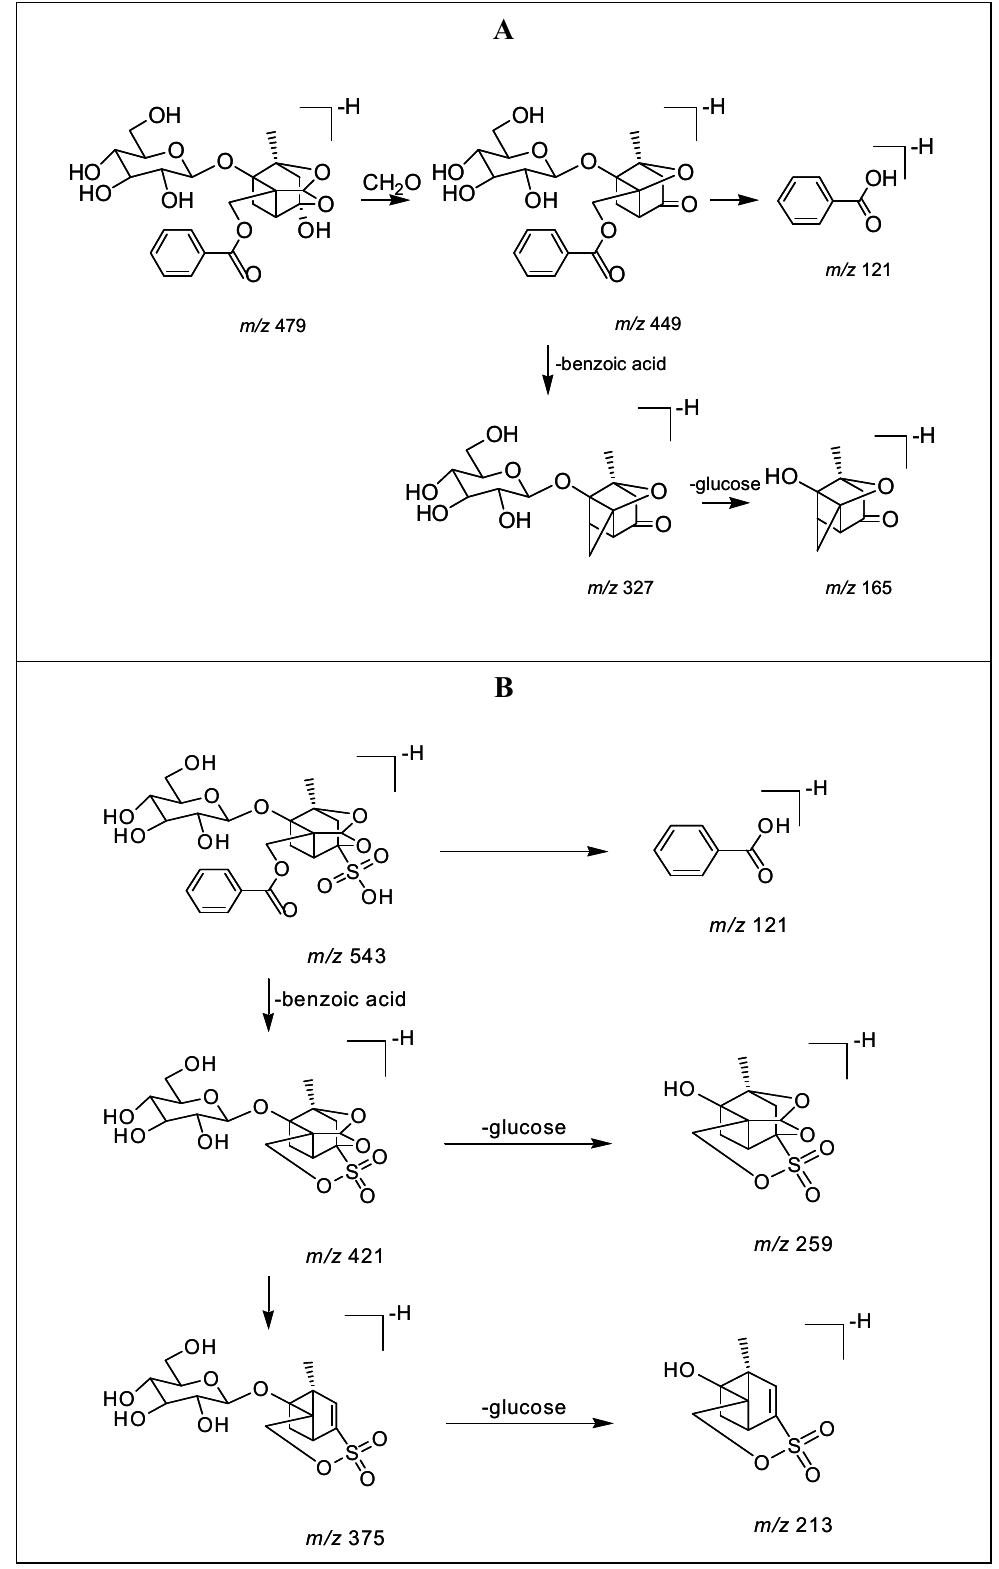
Figure 3. Rationalization of fragments. ( A ) paeoniflorin; ( B ) paeoniflorin